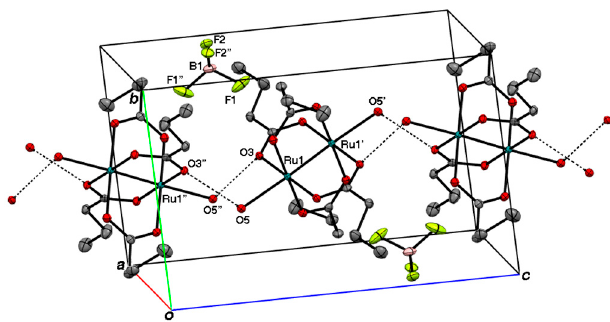
Figure 4. Packing diagram of 3 . Primes ( ′ ) and double primes ( ′′ ) refer to the equivalent positions ( − x, − y, − z) and ( − x, y, 1/2 − z), respectively.